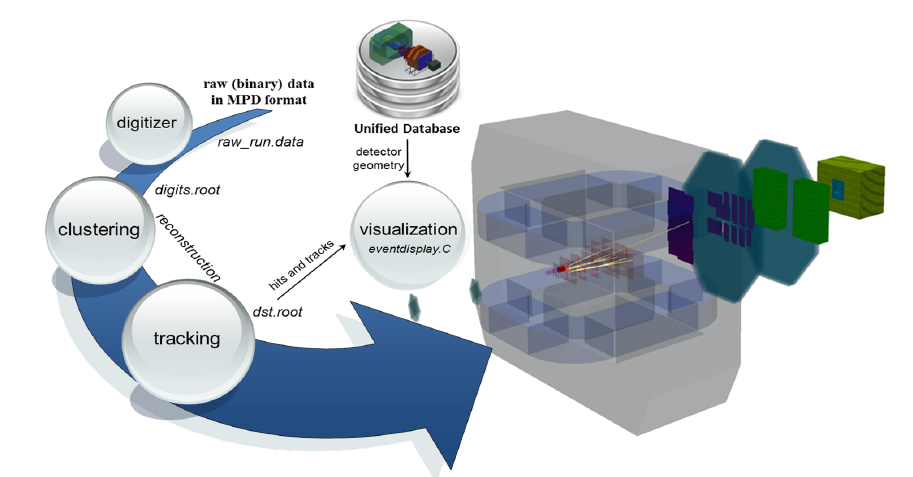
Fig. 7. Visualization of tracks in a carbon-carbon